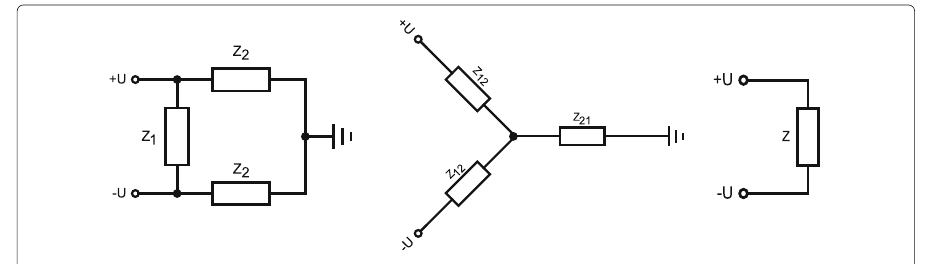
Fig. 1 General lumped element circuit model of a two electrode probe-plasma system in geometric symmetry (left), equivalent star circuit of this system (center), and simplified circuit without coupling to ground due to anti-symmetric voltages applied to the electrodes (right)